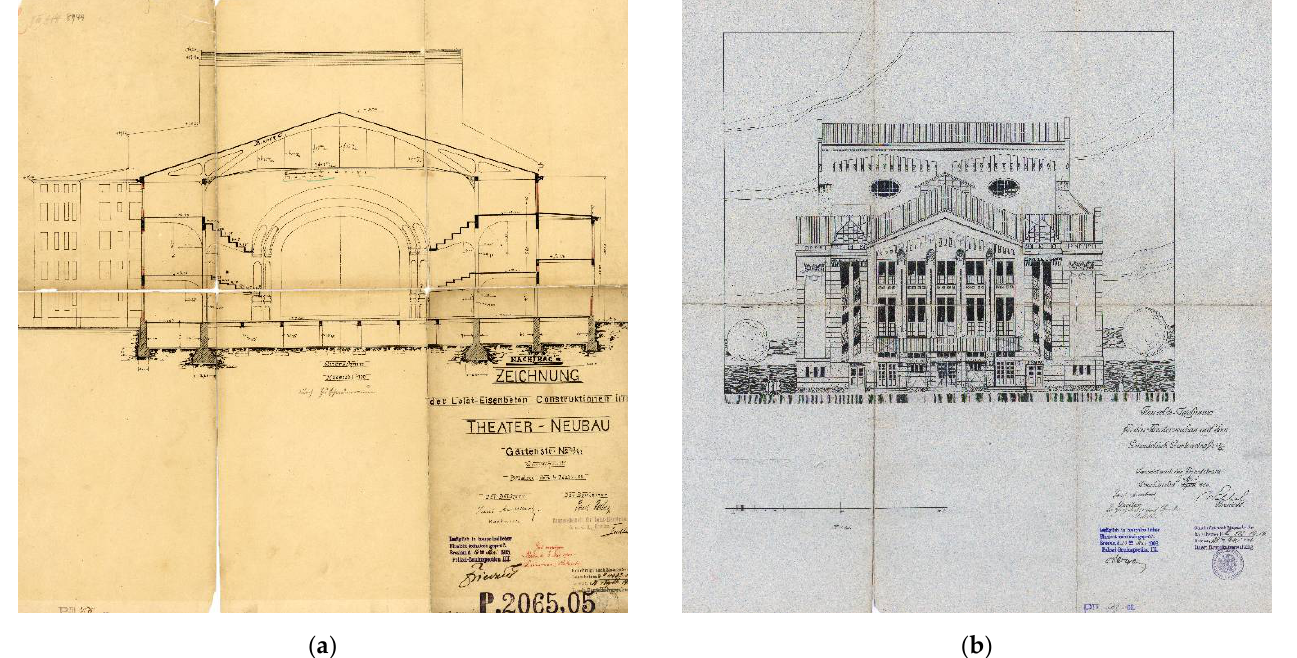
Figure 2. The theater ( Metropol , later Schauspielhaus , and today Teatr Polski ), built in 1905–1908 and designed by Berlin architect Walter Hentschel: ( a ) cross-section and ( b ) front elevation (Wrocław Construction Archive, a branch of the Museum of Architecture in Wrocław).